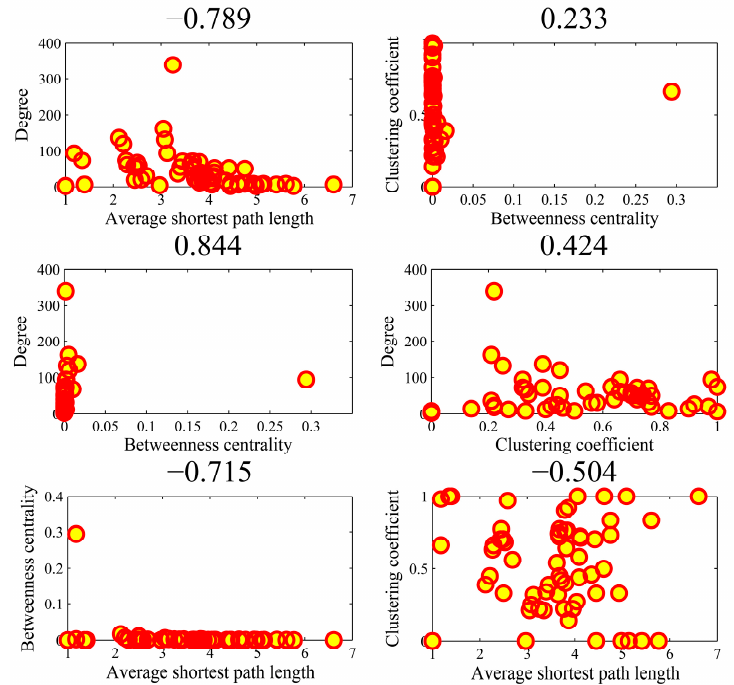
Figure 10. The Spearman rank correlations between the four parameters in the AD (Alzheimer’s disease) genes.